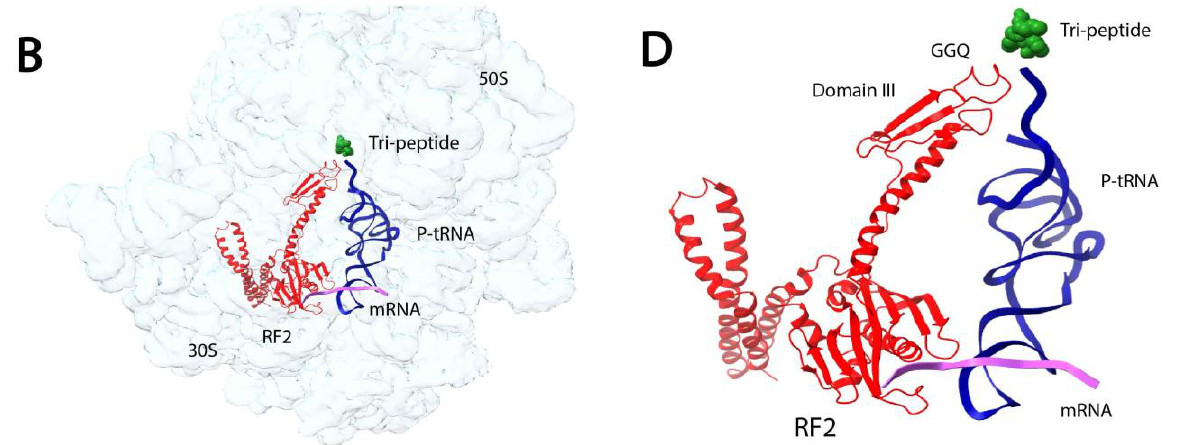
Figure 3. TrEM reveals structural intermediates of release-factor activation during translation termination [89]. ( A , B ) Cryo-EM structures of the E. coli 70S ribosome bound to RF2 in compact ( A ) and extended ( B ) conformations. After incubating the reaction for 24 ms, 25% of the ribosome-bound RF population was in the compact form. At 60 ms, the entirety of the observed population was in the extended form. ( C , D ) Ribosome-bound RF2 in compact ( C ) and extended ( D ) states show the location of the GGQ motif and domain III. RF2 is shown in red, tRNA in blue, mRNA in purple, and the tripeptide in green. The compact state map and model can be accessed with the accession codes EMD-20188 and PDB ID:6OST, respectively. The extended state map and model can be accessed with the accession codes EMD-20193 and PDB ID:6OT3, respectively.